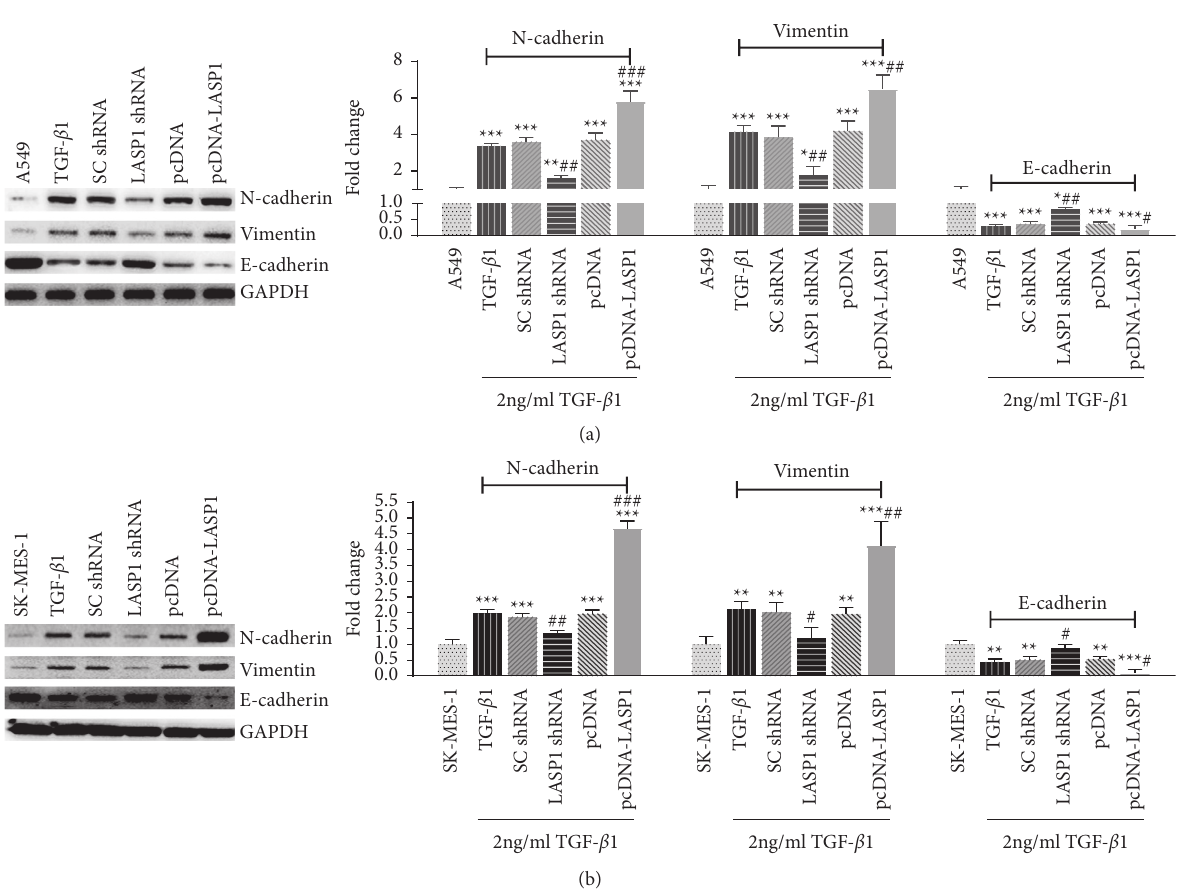
Figure 4: (a-b) LASP1 regulated EMT-related markers expression in A549 (a) and SK-MES-1 (b) cell lines under TGF- β 1 treatment. After 48h coinfection with TGF- β 1 accompanying LASP1 knockdown or overexpression, cell lysates were detected by western blot for EMT- related marker expression, including N-cadherin, vimentin, and E-cadherin. GAPDH was used as reference control. Data were shown as mean ± SD, n � 3. ∗ p < 0 . 05, ∗∗ p < 0 . 01, and ∗∗∗ p < 0 . 001 vs. the cell alone group without TGF- β 1 treatment, and # p < 0 . 05, ## p < 0 . 01, and ### p < 0 . 001 vs. the TGF- β 1-treated noninfection group (TGF- β